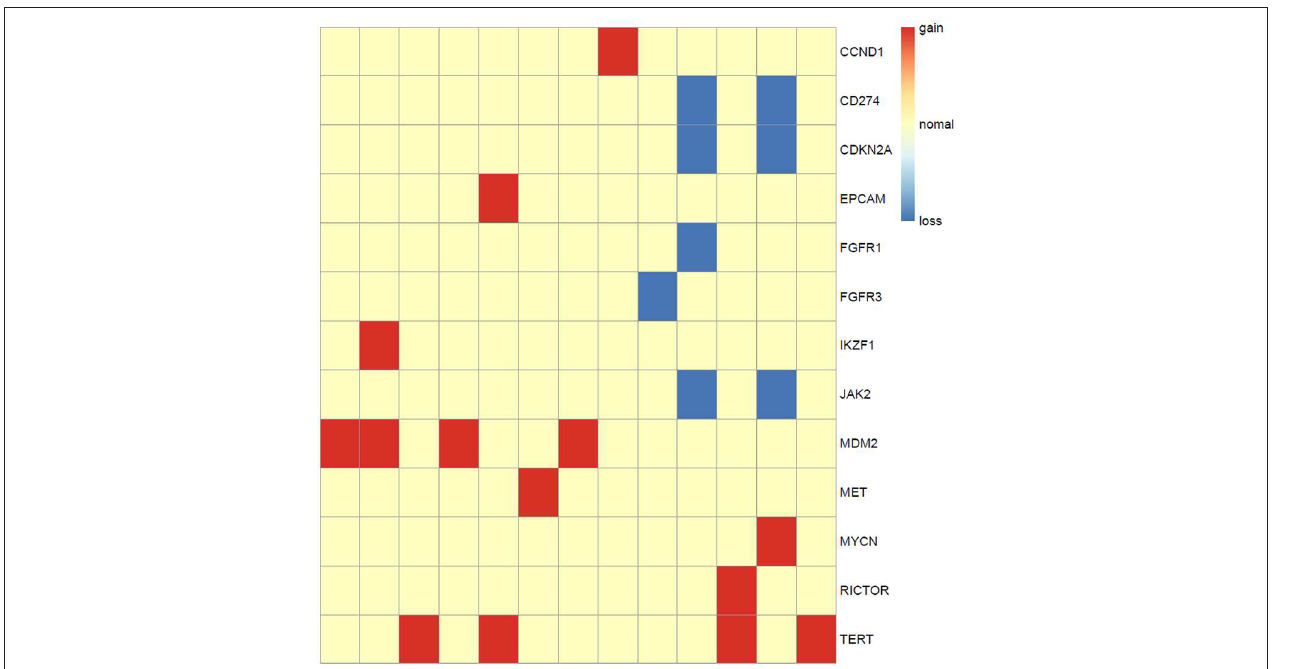
FIGURE 6 | Copy number aberrations in 13 ALK fusion positive NSCLC patients. The names of the aberrant genes are shown in the y-axis, while each column represents a patient. The type of copy number aberrations, including gain, normal, and loss are indicated by red, yellow, and blue,